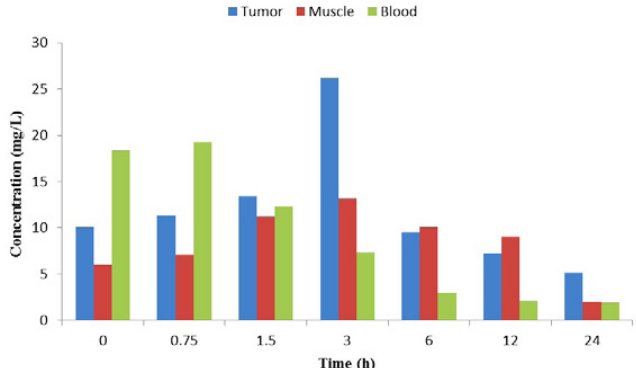
Fig. 10. Boron concentration in blood, normal tissue and tumor tissue for drug with respect to time